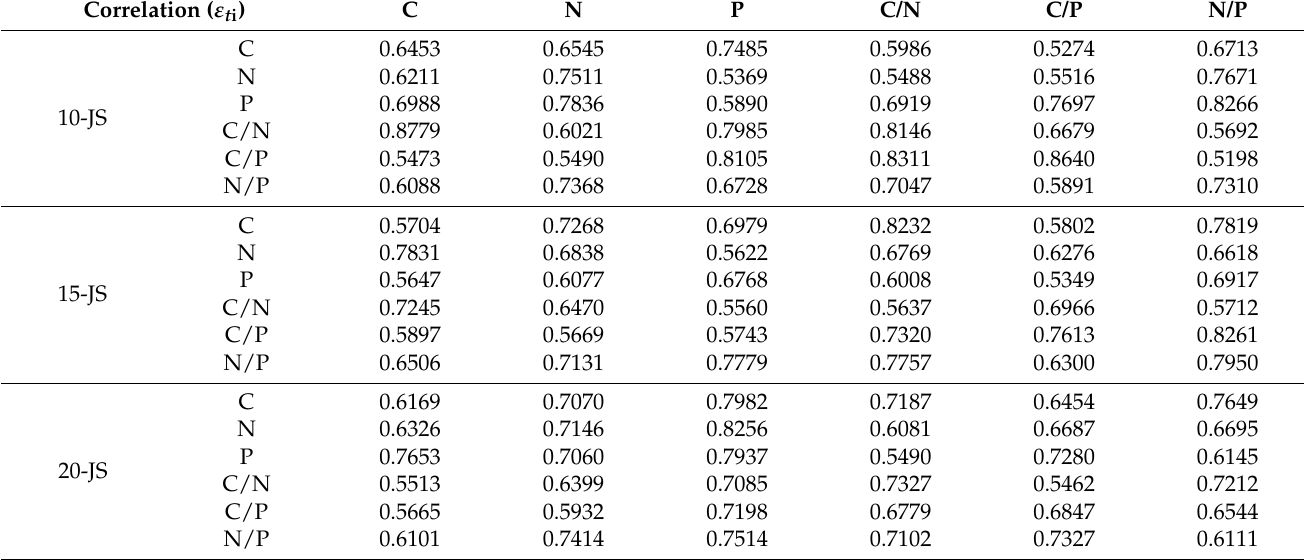
Table 2. Correlation between soil factors and shrub factors under different precipitation patterns.